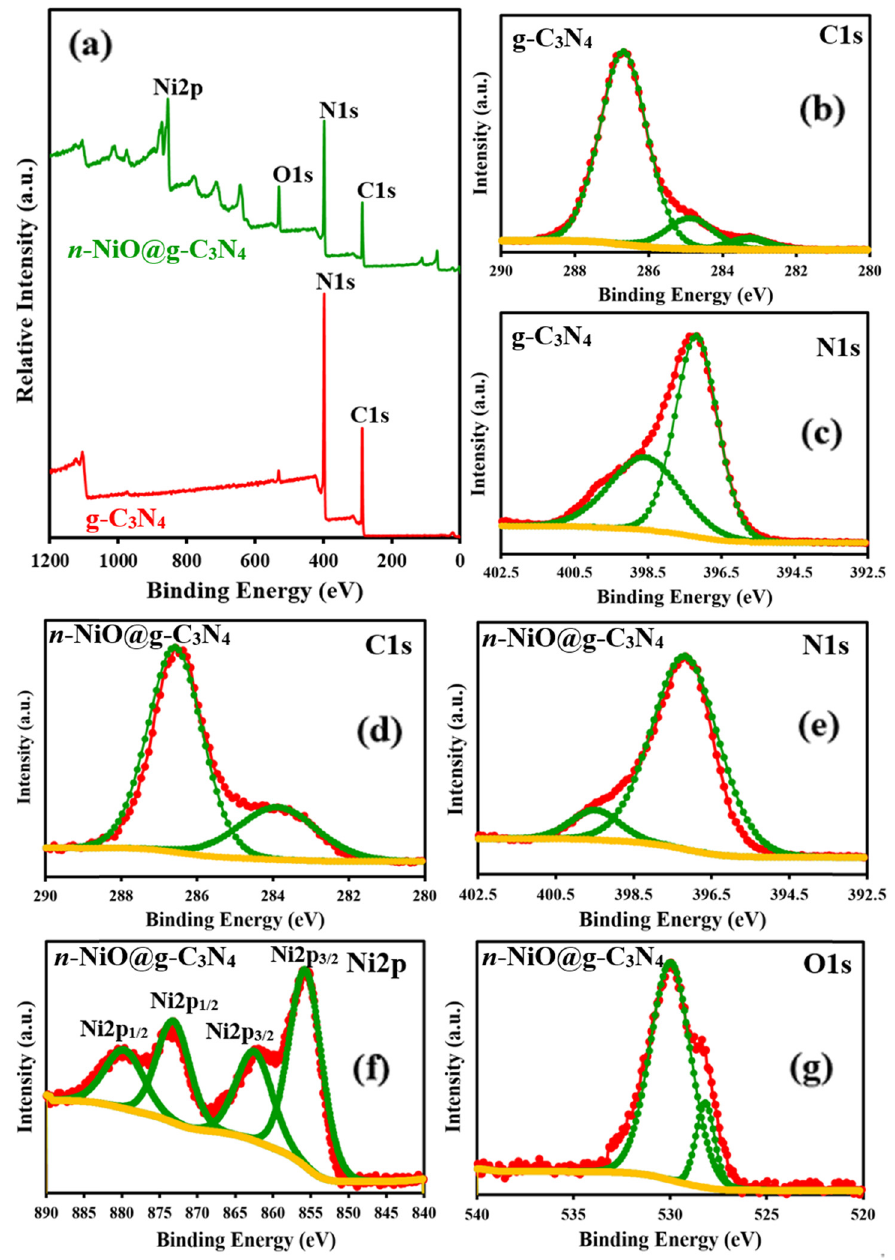
Figure 5: XPS survey scan of g - C 3 N 4 and n - NiO@g - C 3 N 4 ( a ) . High - resolution XPS spectrum of g - C 3 N 4 for C1s peak ( b ) and N1s peak ( c ) . High - resolution XPS spectrum of n - NiO@g - C 3 N 4 for C1s peak ( d ) , N1s peak ( e ) , Ni2p peak ( f ) , and O1s peak ( g )